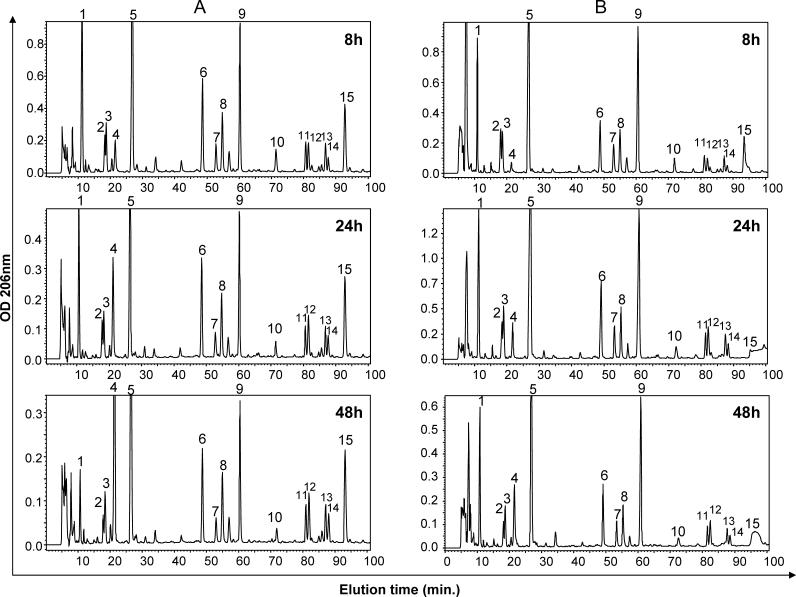
Muropeptide Profile of H. pylori PGPG from parental strain 26695 (A) and its amiA isogenic mutant (B) were purified and digested with the muramidase M1 (mutanolysin). The generated muropeptides were separated by HPLC. The HPLC profiles show muropeptide composition after 8 h, 24 h, and 48 h of bacterial growth. Each peak structure was assigned by MALDI-TOF mass spectrometry and corresponds to a different muropeptide: (1) GM-tripeptide, (2) GM-tetrapeptide, (3) GM-tetrapeptide-glycine, (4) GM-dipeptide, and (5) GM-pentapeptide. Dimers were then eluted: (6) GM-tetrapeptide-tripeptide-MG, (7) GM-tetrapeptide-tetrapeptide-glycine-MG, (8) GM-tetrapeptide-tetrapeptide-MG, and (9) GM-tetrapeptide-pentapeptide-MG. Finally, anhydromuropeptides were eluted: (10) G(anh)M-pentapeptide, (11) and (12) G(anh)M-tetrapeptide-tripeptide-MG, (13) and (14) G(anh)M-tetrapeptide-tetrapeptide-MG, and (15) G(anh)M-tetrapeptide-pentapeptide-MG.